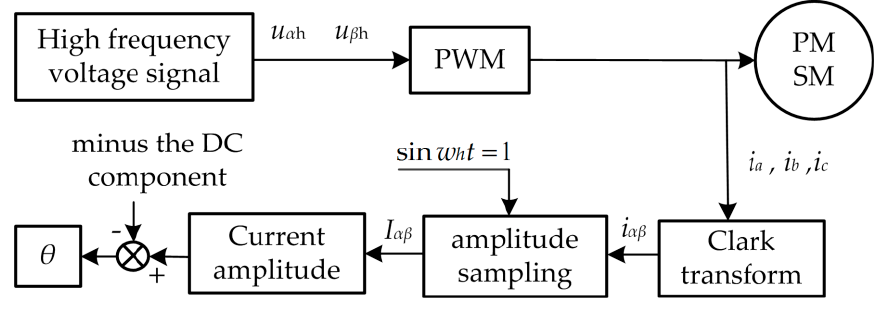
Figure 5. The extraction of rotor position.